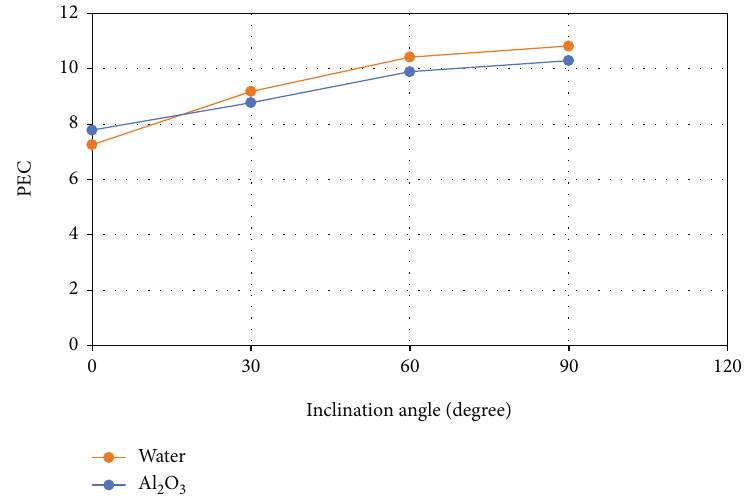
Figure 9: PEC for water and nano fl uid 0.2 as a function of magnetic fi eld direction ( Ha = 40, Da = 0 : 1 ).